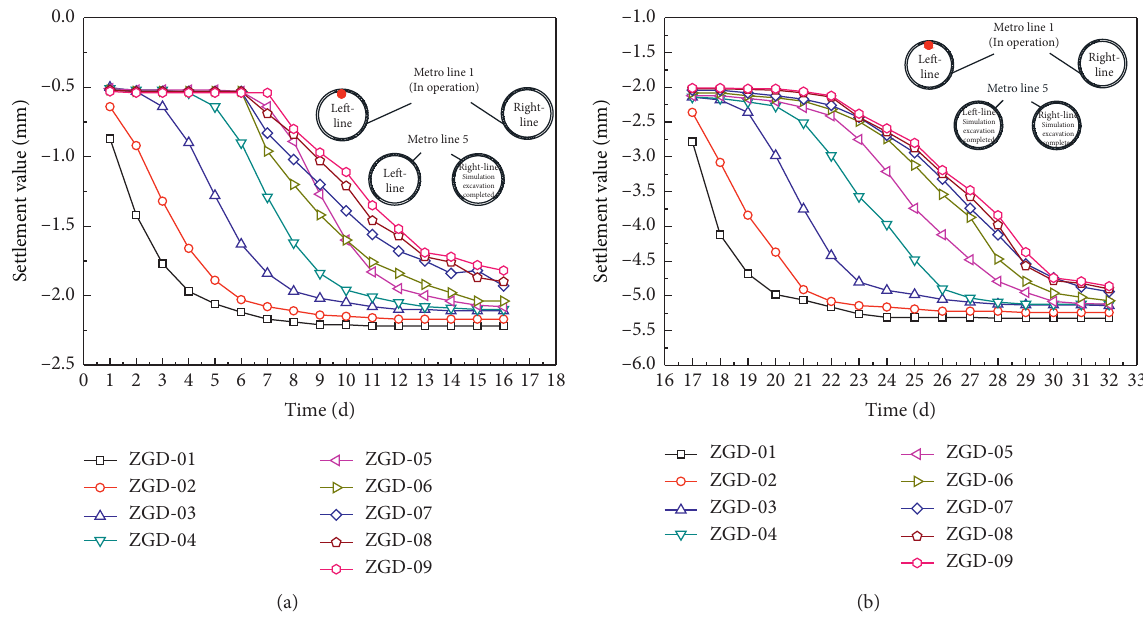
Figure 4: Time history curve of tunnel arch crown settlement of left line of line 1 caused by excavation construction of line 5 (numerical results). (a) Right-line tunnelling. (b) Left-line